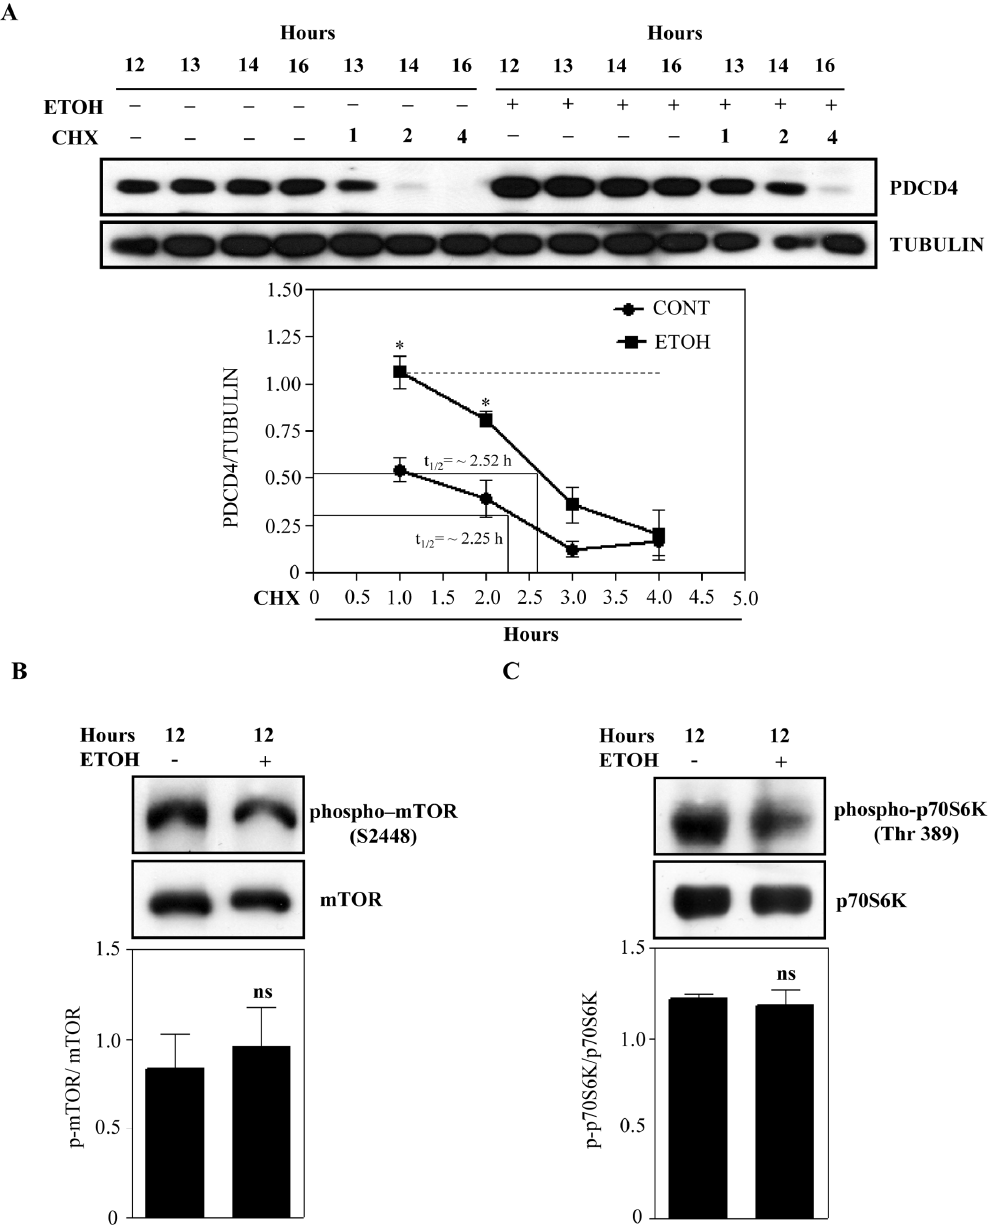
Figure 2. Ethanol does not stabilize PDCD4 protein. ( A ) Neuroblasts were incubated with or without ETOH (4 mg/ml) for the times indicated followed by CHX (20 m M) treatment for 1–4 h. Total cell lysates were resolved by SDS-PAGE and immunoblotted with antibodies against PDCD4 or tubulin (top panel). The signals were quantitated by densitometry and the ratios of PDCD4 over tubulin were plotted (bottom panel). Two-way analysis of variance (ANOVA) with Bonferroni post hoc tests was carried out to establish statistical significance.*p , 0.05 when compared with untreated control. ( B ) Top panel represents the immunoblot analysis against phosphorylated form of mTOR (S2448) and mTOR from untreated and ETOH treated cell lysates. The signals for the bands were quantitated densitometrically and the intensity of phospho-mTOR relative to the levels of mTOR protein expression was calculated (ns not significant when compared to control as determined by student’s t-test) (lower panel). ( C ) Western blot analysis of phospho-p70S6Kinase (Thr 389) and p70S6Kinase on untreated and ETOH treated whole cell lysates (top panel). Bottom panel illustrate the densitometric quantification of phospho-p70S6Kinase to total p70S6Kinase (ns, not significant compared with untreated control as analyzed by student’s t-test). n=3. doi:10.1371/journal.pone.0098080.g002 line). Altogether, these data suggests that ETOH mediated PDCD4 protein increase is not due to PDCD4 protein stability (Figure 2A, B and C). In view of the fact that PDCD4 is regulated by miR-21 [51,52], we next determined if ethanol regulates PDCD4 at the post- transcriptional level. To assess this, we first tested whether ETOH